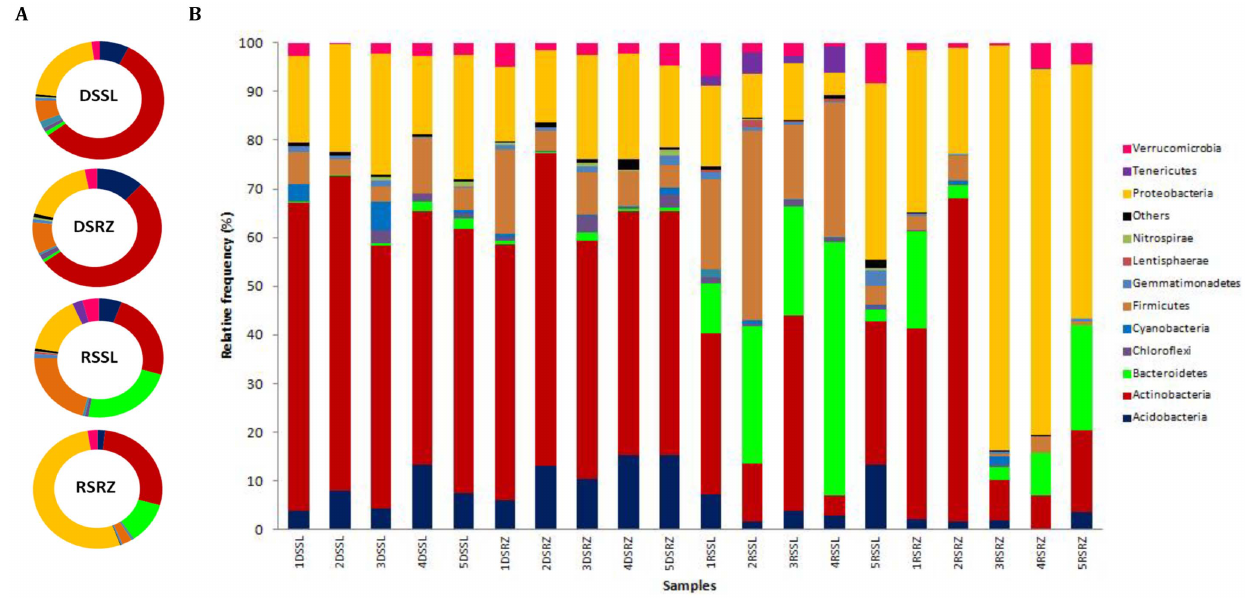
Figure 5. Classified sequences divided by phyla with relative frequencies higher than 1% (for the majority of the samples). A - Distribution of phyla, divided by samples. B - Samples obtained for the five different sampling sites from bulk soil during the dry season (DSSL), rhizosphere during the dry season (DSRZ), bulk soil during the rainy season (RSSL) and rhizosphere during the rainy season (RSRZ). ‘‘Others’’ include eighteen phyla with relative frequencies lower than 1%: AD3, Armatinonadetes, Candidatus Poribacteria, CCM11b, Chlamydiae, Elusimicrobia, Fibrobacteres, Fusobacteria, NC10, Planctomycetes, SC3, SC4, SPAM, Spirochaetes, Synergistetes, TM7, WPS-2 and WS3.